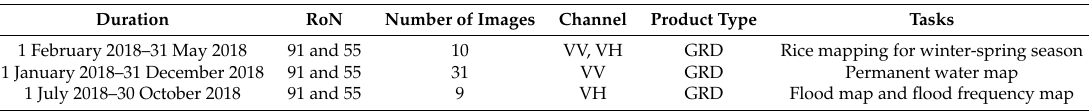
Table 2. S1A data used in the